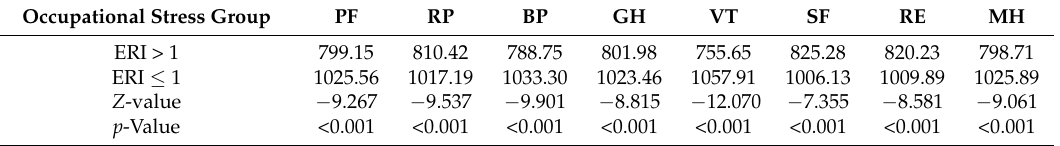
Table 5. Comparison of the quality of life among stressed (an ERI score > 1) and non-stressed (an ERI score ≤ 1) copper-nickel miners.